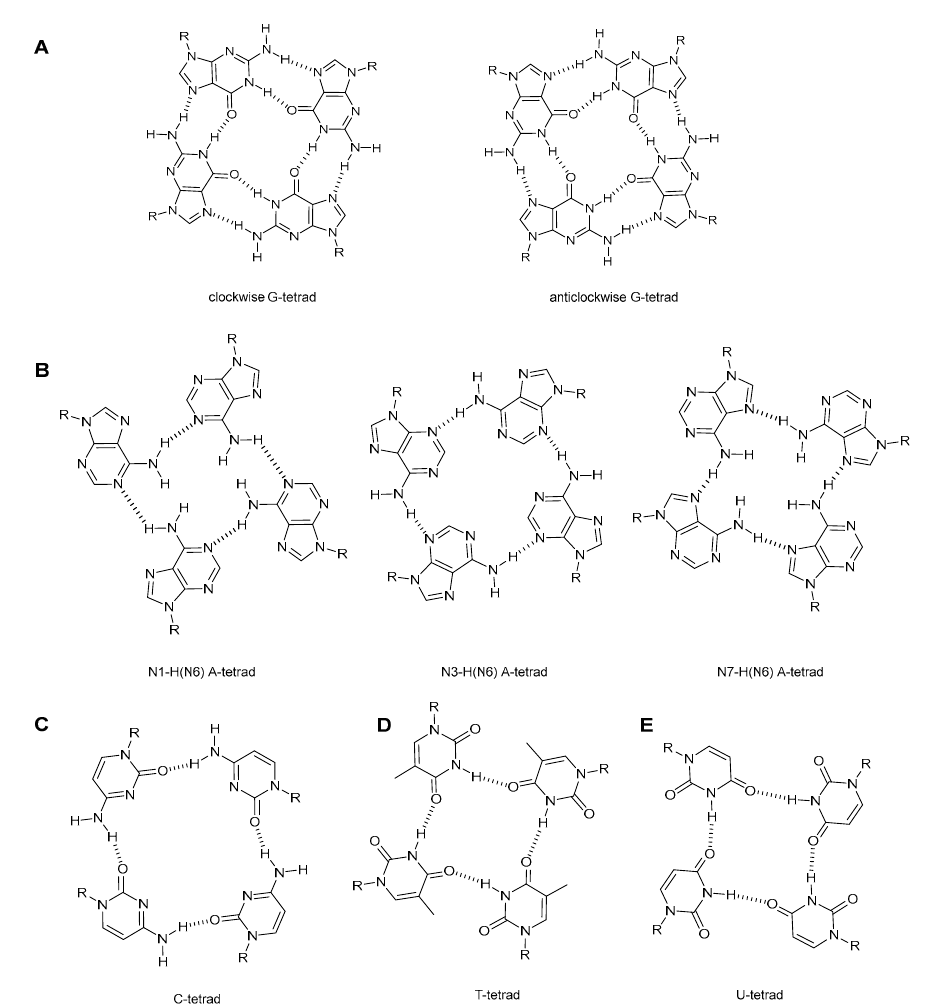
Figure 1. Schemes of the different homotetrads discussed in the text. ( A ) G-tetrads in their two possible orientations (clockwise and anticlokwise); ( B ) The three most common A-tetrads; ( C – E ) C-, T-, and U-homotetrads, respectively.